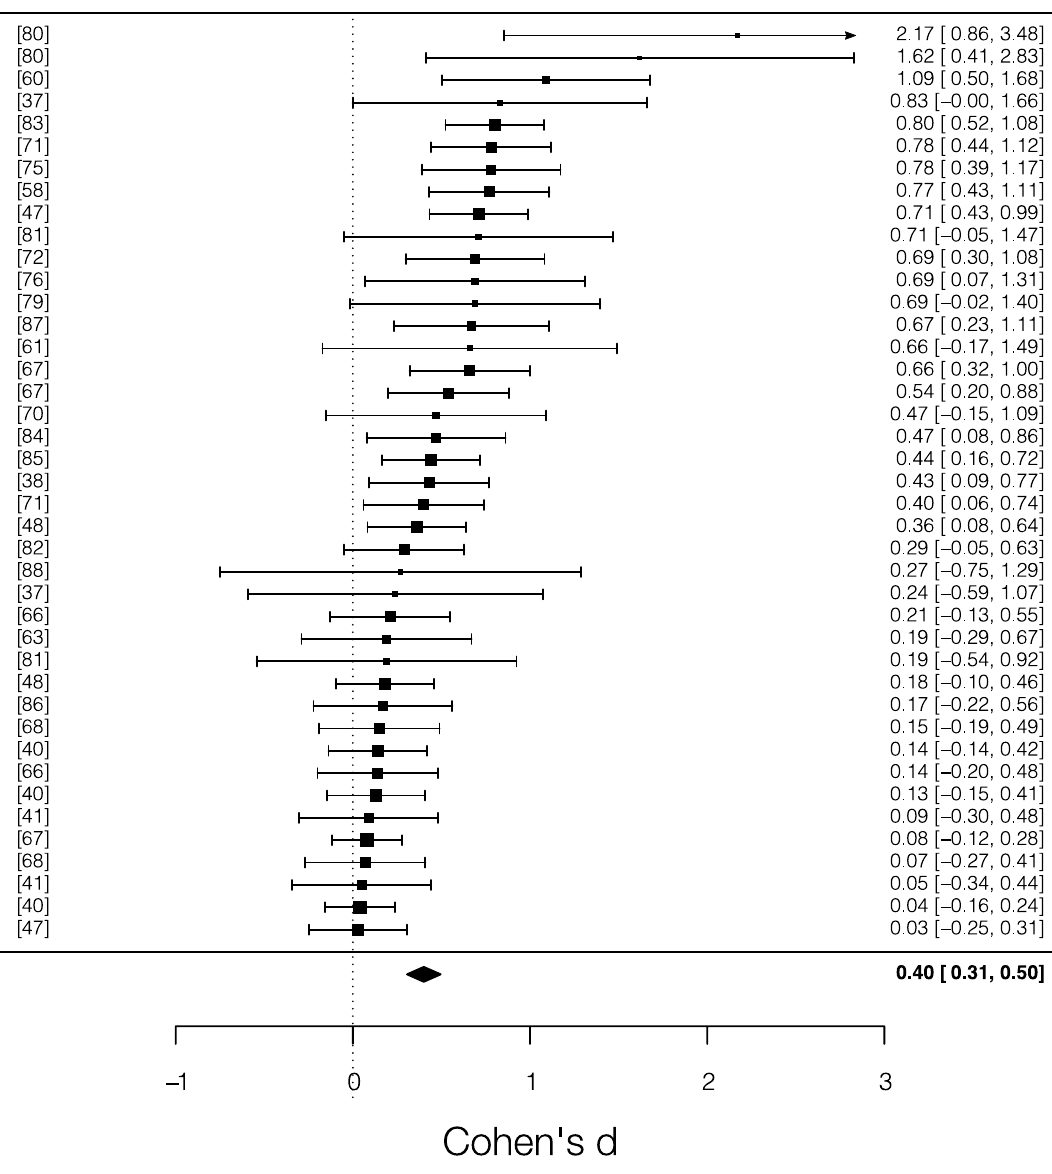
Figure 4. Forest plot of the studies that used RTs as main dependent variable included in the meta-analysis. Each row corresponds to one experiment and the lines beside each square represent 95% confidence interval. The size of each square represents the weight of the study. The diamond at the bottom represents the cumulative effect size with 95% confidence interval. Higher positive values indicate higher behavioral modulation in the cerebellar TMS